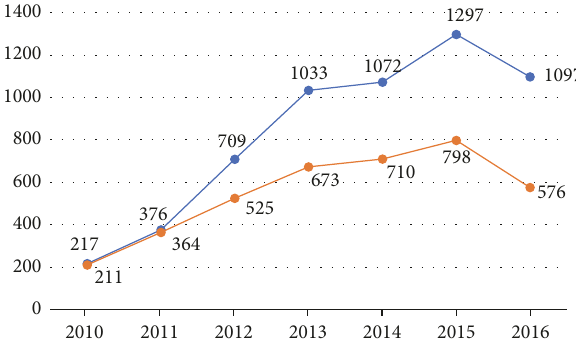
Figure 1: Number of patients followed (orange line) and number of samplings received and performed at CILM (blue line) from January 2010 to November